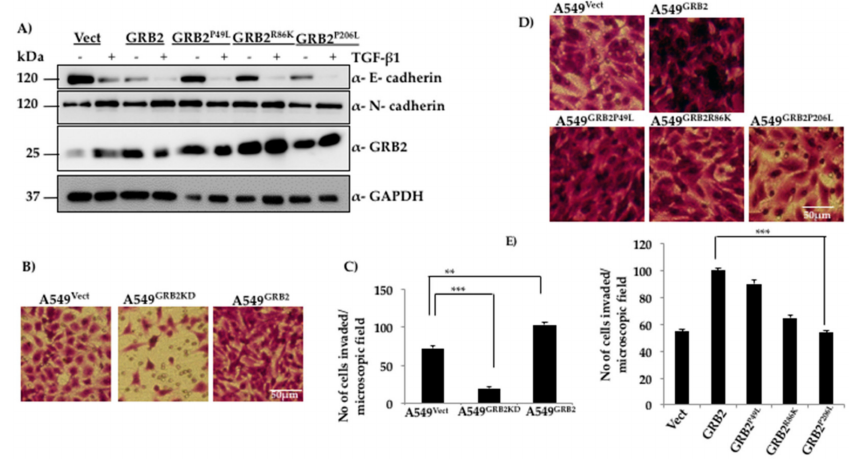
Figure 4. Functional N-terminal and C-terminal SH3 domains are critical for reducing E-cadherin expression and promoting invasion of A549 cells, respectively. ( A ) A549 cells were infected with lentivirus particles generated using vector, or plasmids expressing WT GRB2 or its mutants (GRB2 P49L , GRB2 R86K and GRB2 P206L ), selected with puromycin, and EMT was as described in Figure 1. Cells were then lysed and the protein extracts were subjected to Western blot analysis by probing with antibodies against E-cadherin, N-cadherin, and GRB2. GAPDH was used as the loading control; ( B ) Matrigel-coated invasion assay inserts were seeded with 2 × 10 5 cells of A549 Vect , A549 GRB2KD and A549 GRB2 in 200 µ L of serum-free media on the upper chamber of the insert. The well below was filled with complete media containing 20% FBS. The cells were incubated for 40 h at 37 ◦ C, the cells which had invaded through the Matrigel were fixed, washed and stained with crystal violet, and imaged under a 10 × objective lens; ( C ) Cells in four random fields per sample were counted to quantify the number of cells that had invaded. Three independent sets of experiments were carried out to calculate significance. (** p < 0.01, *** p < 0.001); ( D ) Matrigel-coated invasion assay inserts were seeded with 2 × 10 5 cells of A549 Vect , A549 GRB2 , A549 GRB2P49L , A549 GRB2R86K and A549 GRB2P206L per 200 µ L of serum-free media in the upper chamber of the insert. The well below was filled with complete media containing 20% FBS. The cells were incubated for 40 h at 37 ◦ C; the cells that had invaded through the Matrigel were fixed, washed and stained with crystal violet and imaged under a 10 × objective lens; ( E ) Four random fields per sample were imaged and the cells were counted to quantify the number of cells that had invaded through the Matrigel. Three independent sets of experiments were carried out to calculate significance. (** p < 0.01, *** p <